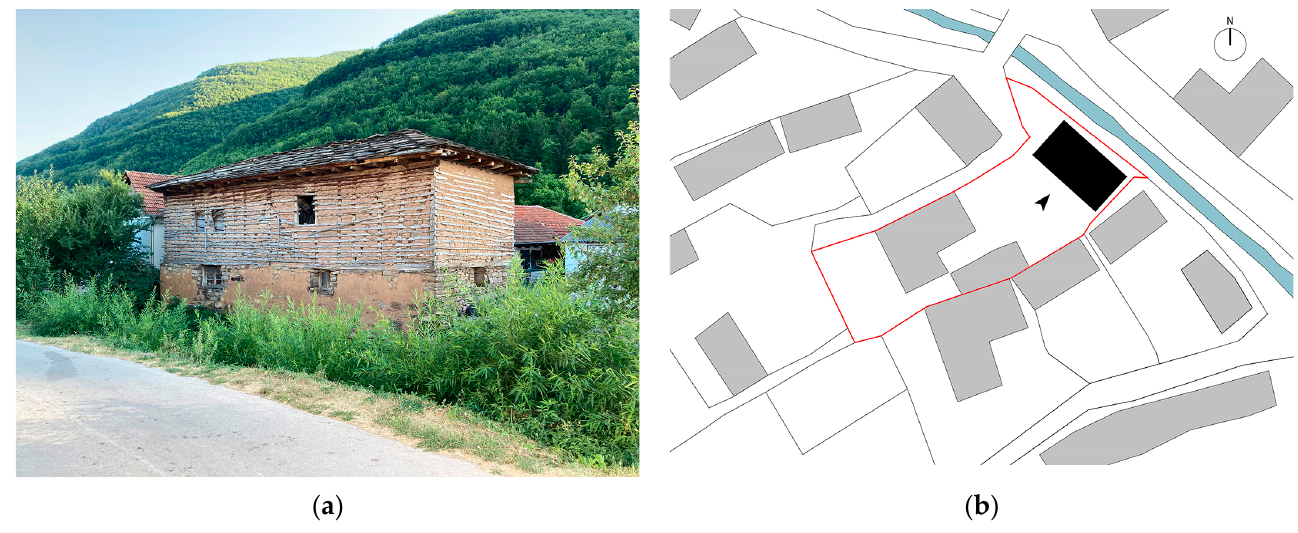
Figure 2. Dojkinci: ( a ) Country barn (photo: M. Stanimirovic, 2023), ( b ) Situation plan. The usual procedure of renovating rural houses in this area involved several opera- tions, which were mostly justified by the amount of financial investment. First, the roof covering is changed. Tiles are installed instead of stone slabs, because they are lighter, cheaper and more available. Moreover, wooden windows are removed and PVC windows are installed instead. Finally, the walls are insulated with EPS, from the outside. The white colour is often avoided, in order to cancel the earlier appearance, which is, according to the peasants, a symbol of poverty. The problem described in the literature concerns the internal organisation of village reconstructions, which is usually not done by architects